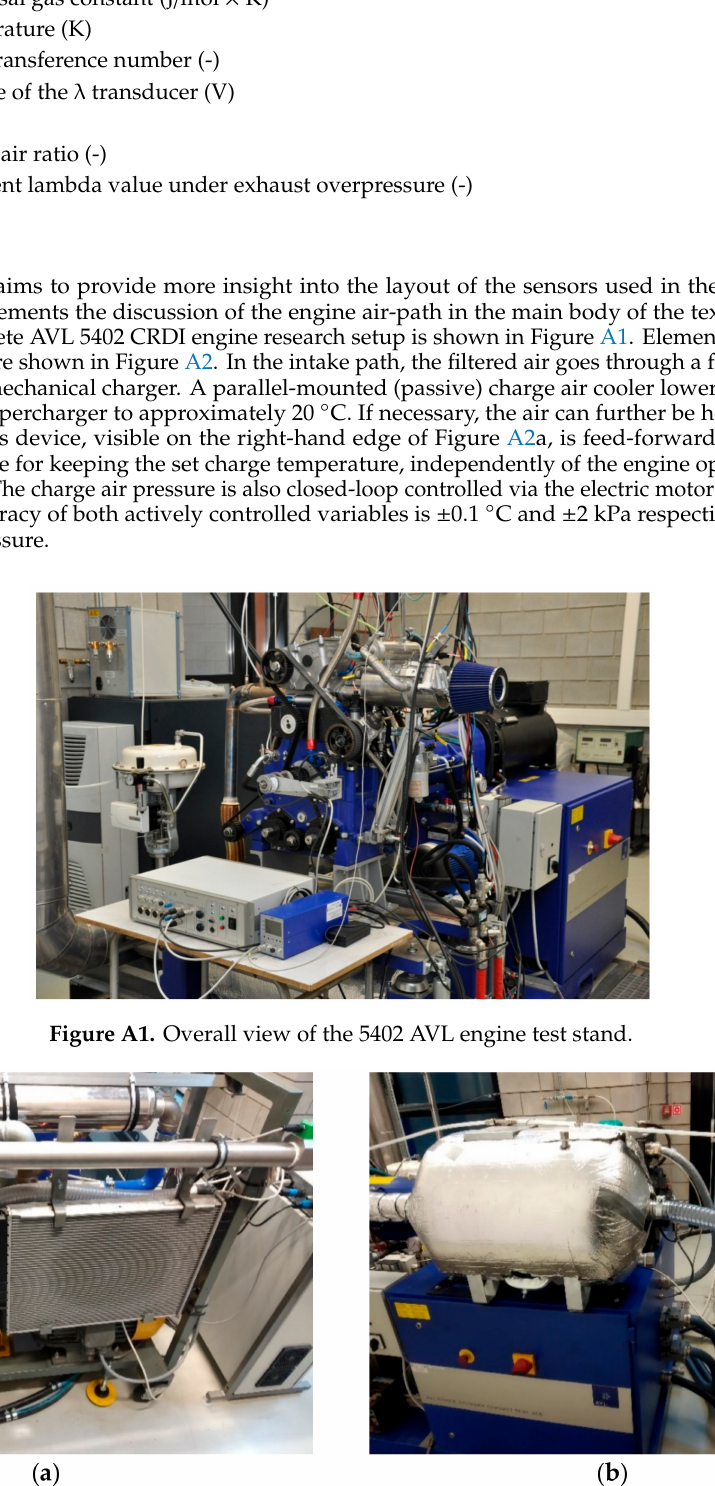
Figure A2. The intake air preparation system; ( a ) airflow meter, supercharger and the charge air cooler; ( b ) pulsation-reducing intake